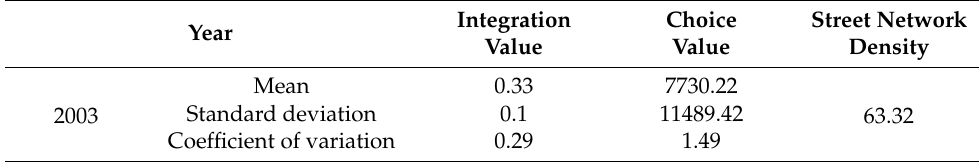
Table 1. Matao Village spatial form indicator.